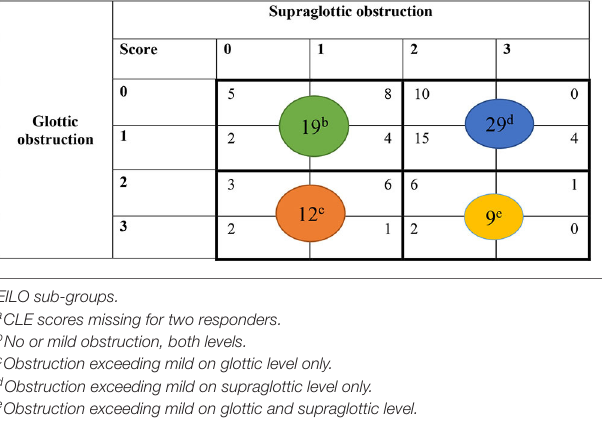
TABLE 4 | Scores on patient reported outcome measures among participating adolescents with exercise induced laryngeal obstruction (EILO). N